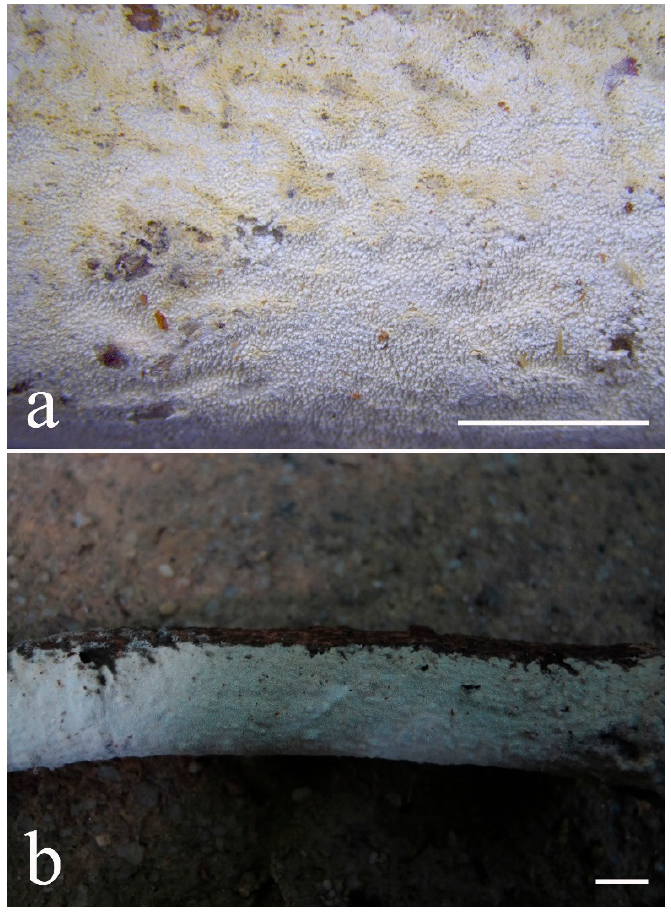
Figure 24. A basidiocarp of Xylodon damansaraensis (LWZ 20180417-20, holotype).—Scale bars: a = 5 mm; b = 1 cm.